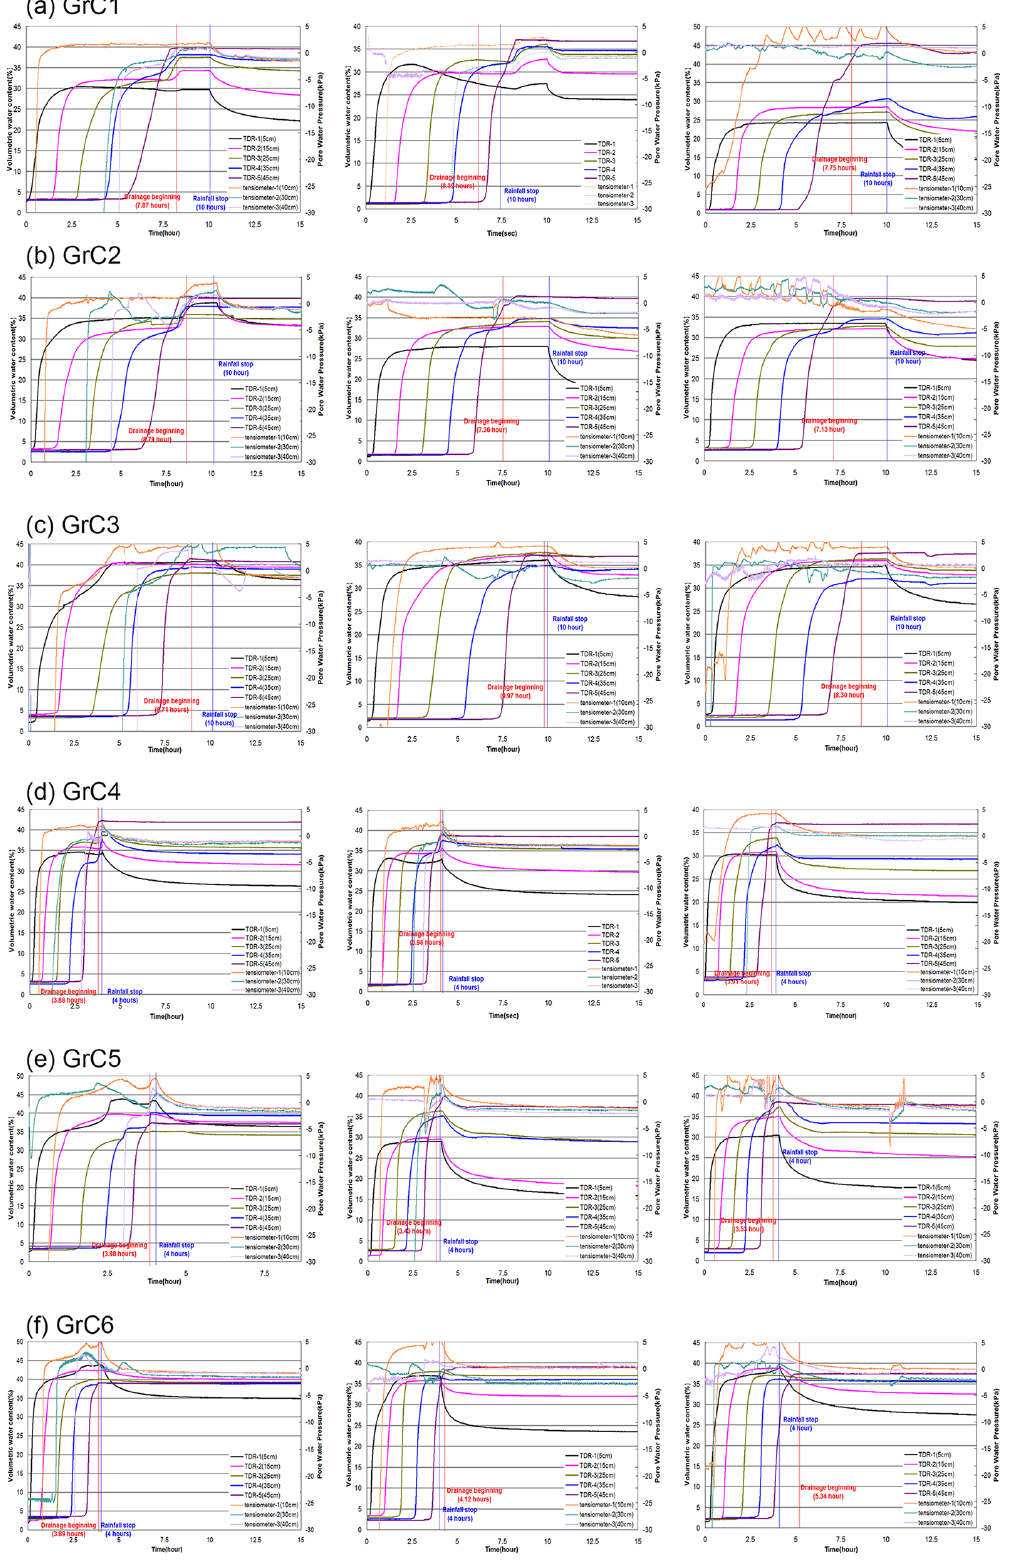
Figure 5. Volumetric water contents of the weathered granite soil in each test condition. (a) GrC1, (b) GrC2, (c) GrC3, (d) GrC4, (e) GrC5 and (f)